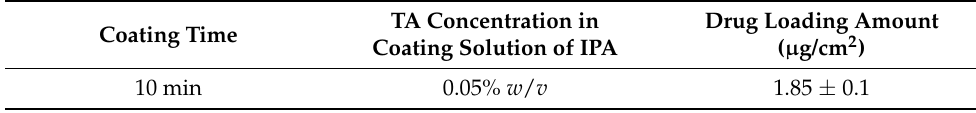
Figure 1. Schematic diagram for manufacturing of TA-coated silicone breast implant. Table 1. Loading amount of TA after coating on the silicone breast